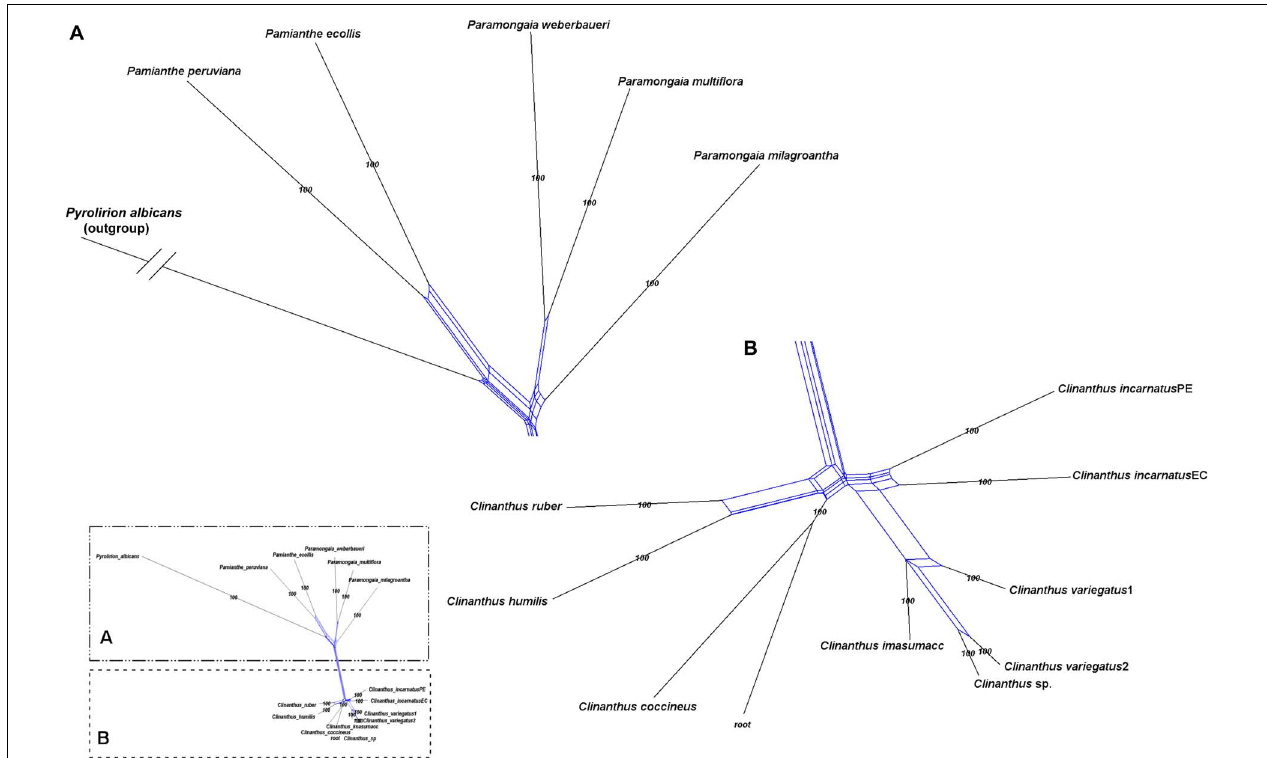
FIGURE 6 | Equal angle 360 ◦ hybridization network generated by SplitsTree v. 4.15.1 based on the 99% taxon coverage supermatrix (70 nuclear genes) across the tribe Clinantheae. Numbers above branches are percentages from 300 bootstrap iterations. The entire network is shown in the inset, with subclades (A) and (B) magnified for